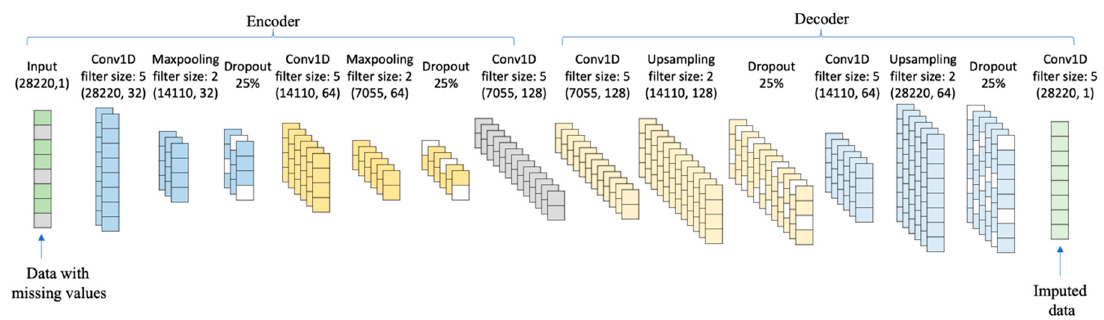
Figure 3. The network architecture of SCDA. The sparse convolutional denoising autoencoders (SCDA) model consists of multiple convolution layers in a hierarchical way, and each convolution layer is regularized by an L 1 penalty. SCDA takes corrupted data with missing values as input to learn a hidden representation, and then reconstructs the input based on hidden representations to impute missing values.